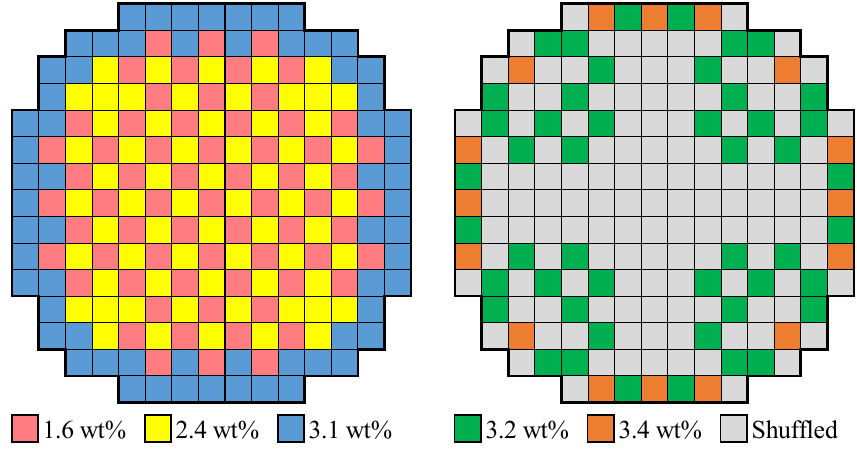
Figure 1. Fuel Loading Pattern (Left: Cycle 1, Right: Cycle